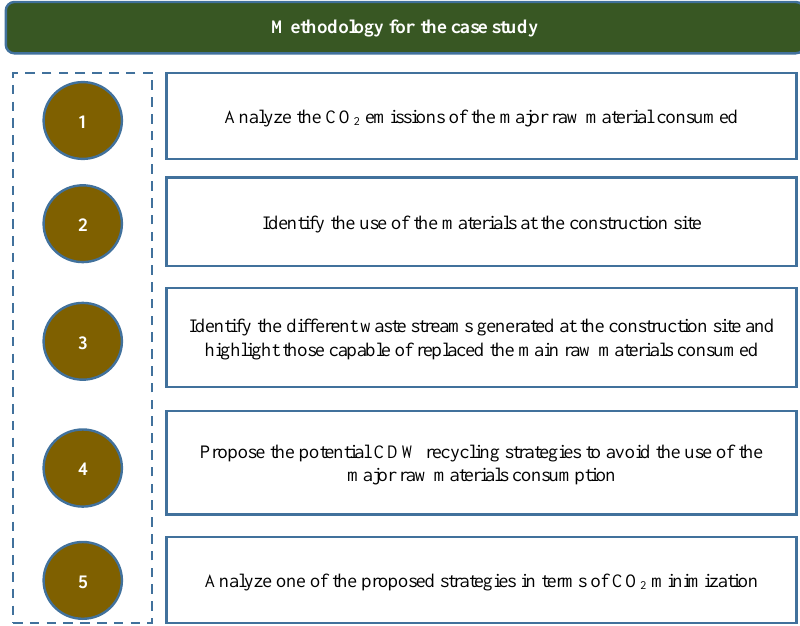
Methodology for the case